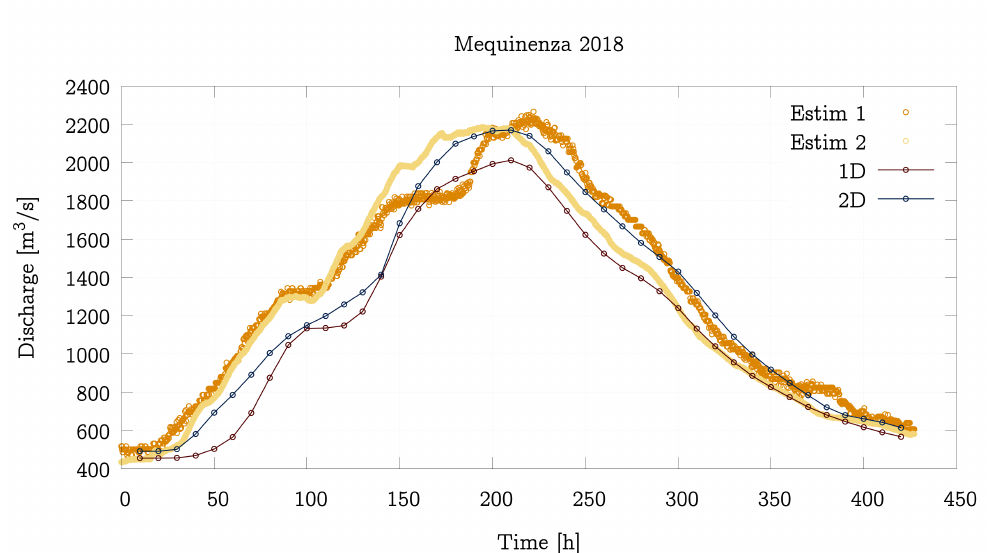
Figure 10. Discharge temporal evolution comparison between the 1D model, the 2D model and the observation at Gelsa (A263) gauging station ( upper ) and comparison between models and estimations in Mequinenza dam (E003) ( lower ) for the 2018 event.